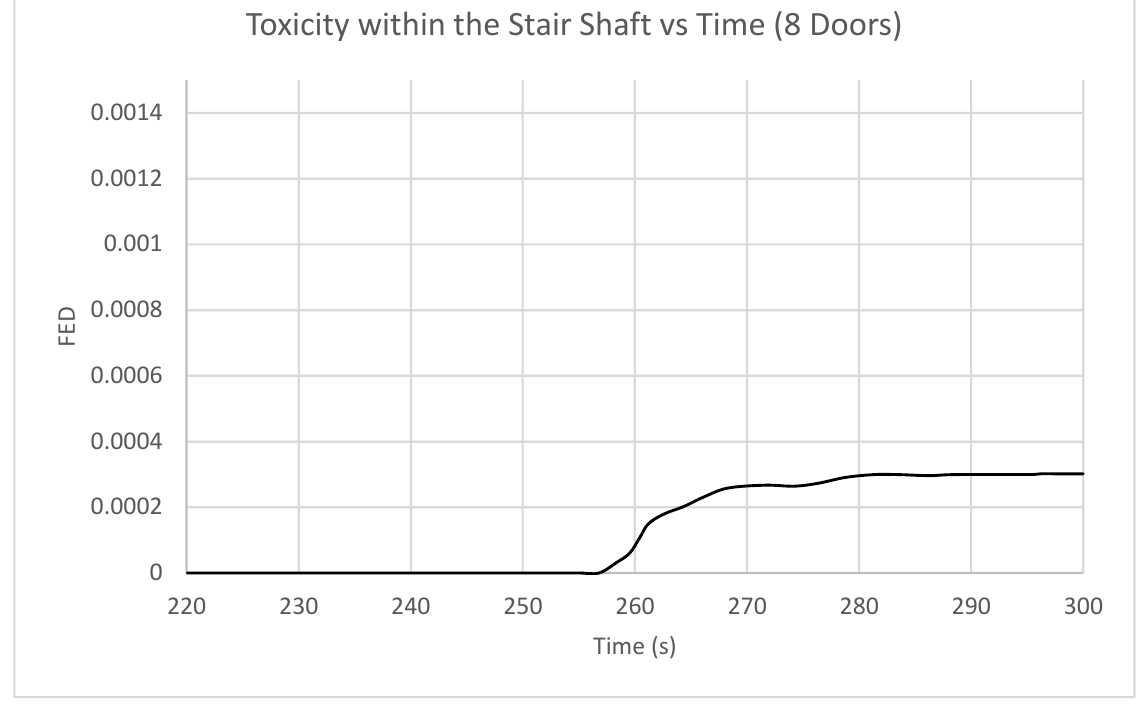
Figure 13. Toxicity within the stair shaft with 8 doors open.